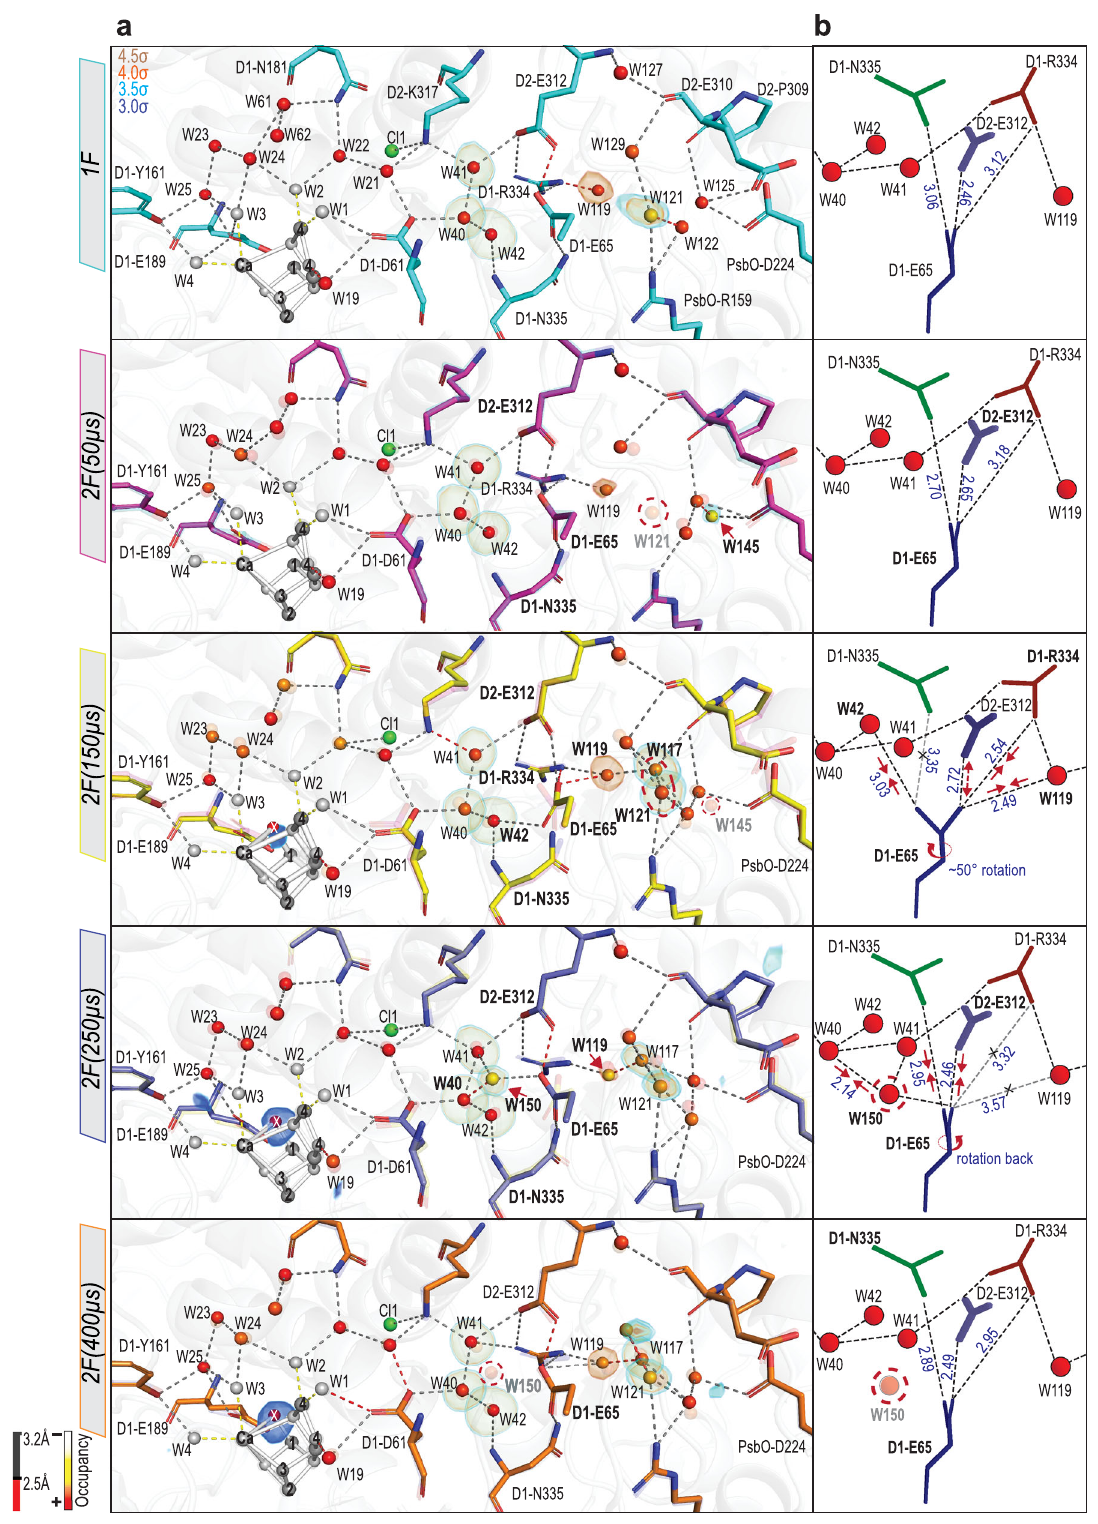
(Fig. 3a, c). In the 2 F(200 ms) data (i.e. S 3 ), its electron density drops signi fi